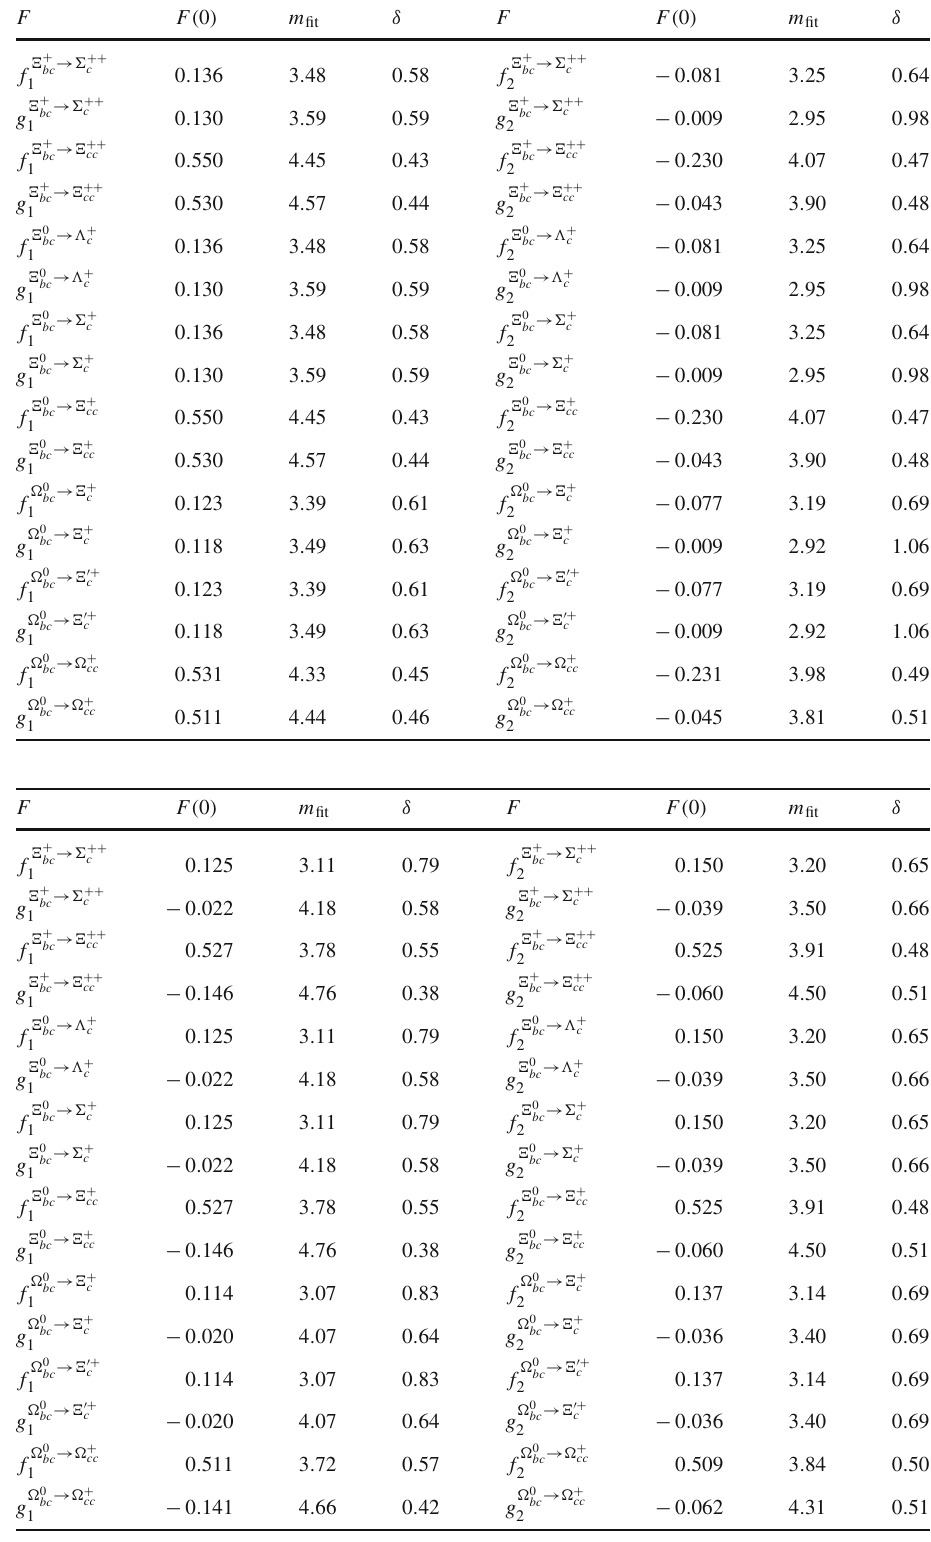
Table 14 Same as Table 8 but for the b decays of bottom–charm baryons with scalar ( 0 + ) diquarks